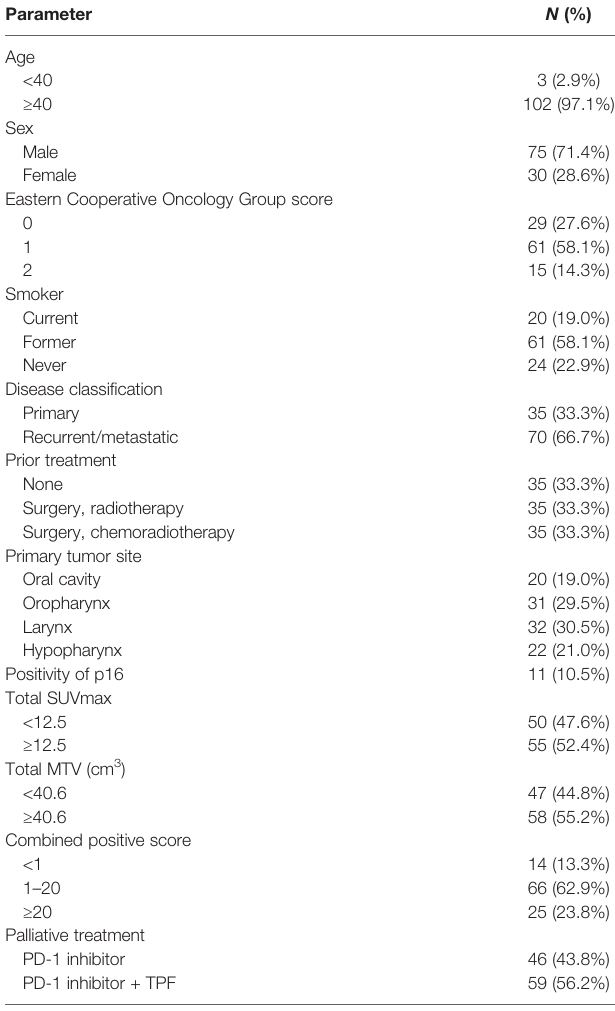
TABLE 1 | Baseline data of the enrolled 105